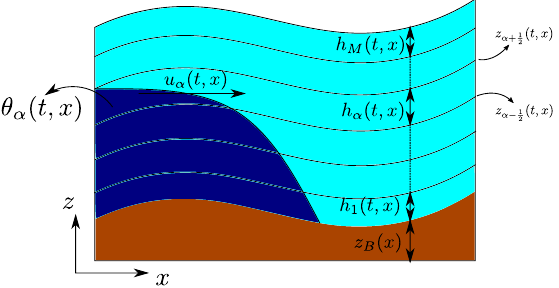
Figure 1. Sketch of the multilayer